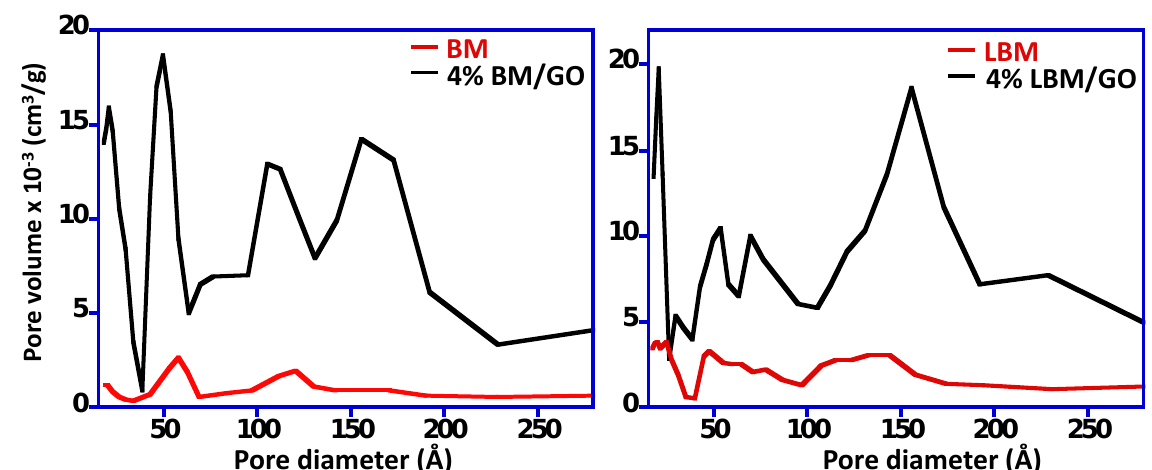
Figure 4. Pore distribution curves of 4% BM/GO and 4% LBM/GO composites.